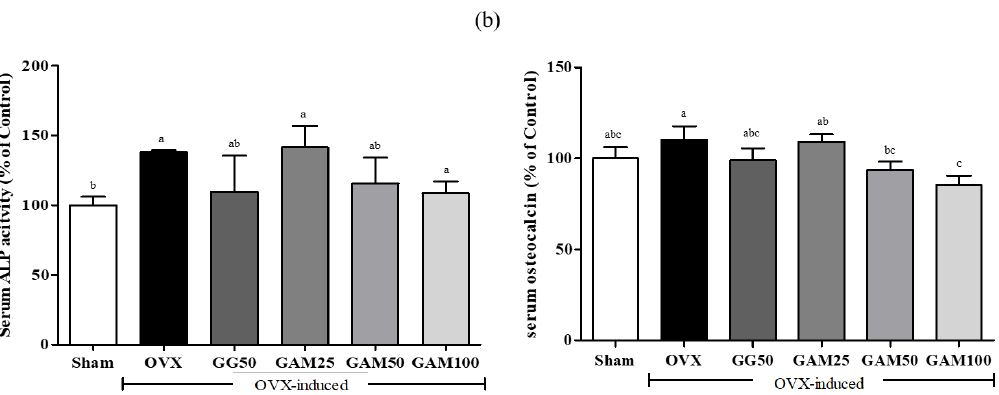
Figure 5. Effects of GAM on bone formation biomarkers in OVX-induced rat models. The effects of GAM on ( a ) ALP and ( b ) OC were evaluated using ELISA kits. a–c Mean values with different letters differed significantly ( p < 0.05) among groups, as shown by Tukey’s test.